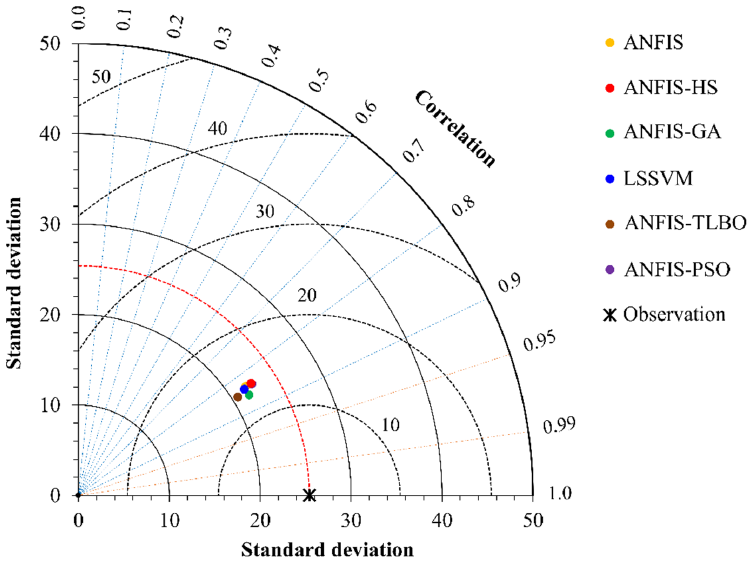
Figure 8. Taylor diagram of the predicted COD by ANFIS-based and LSSVM models using best input combination and data set during testing phase.